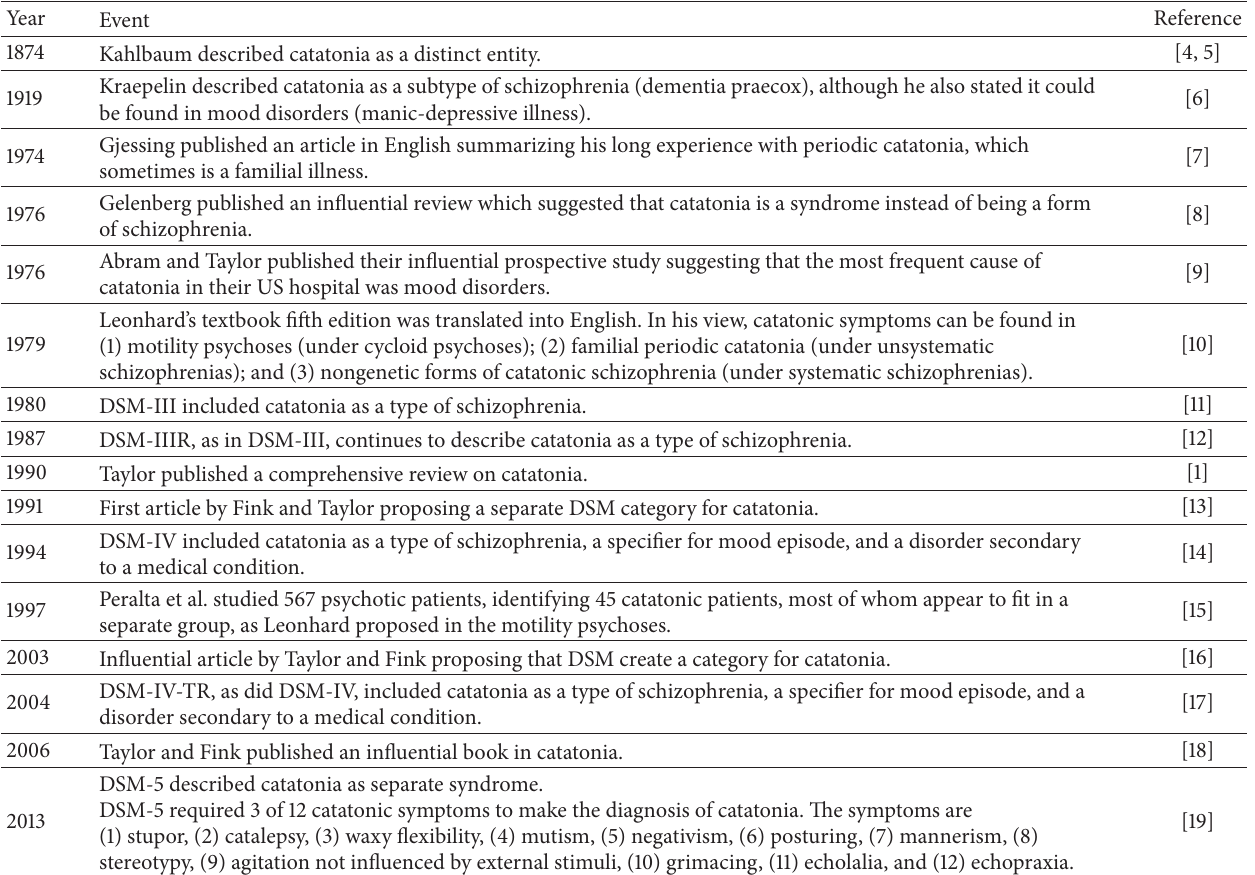
Table 1: Timeline of important events in the history of the diagnosis of catatonia.